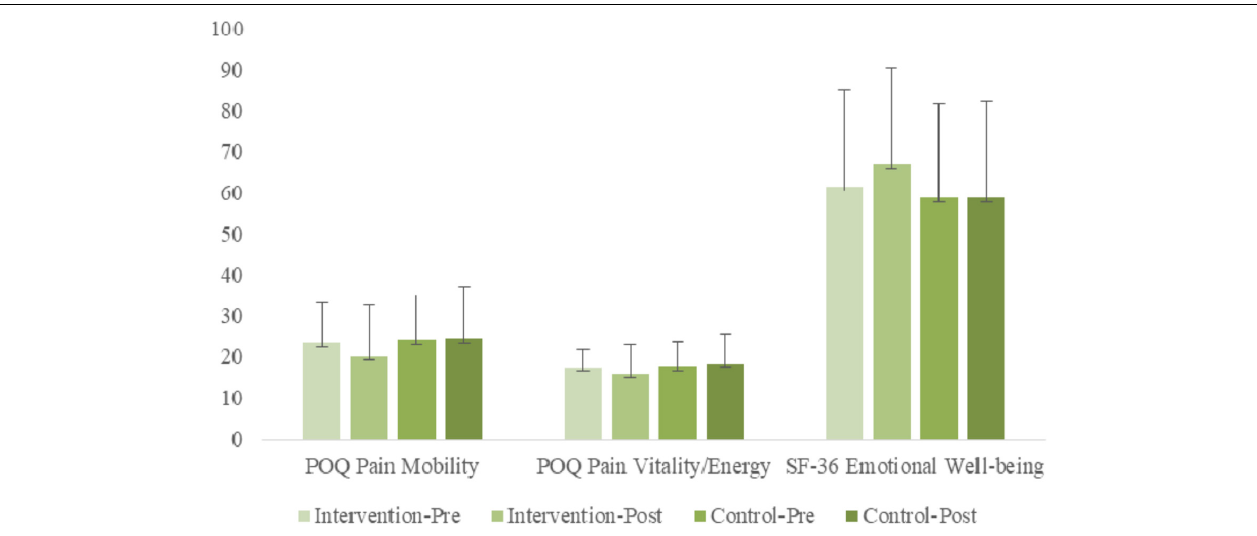
FIGURE 5 | Pre- and post-treatment comparisons of treatment and control groups on strengths variables: POQ Pain Mobility is Pain Impairment in Mobility; POQ Pain Vitality/Energy is Pain Impairment in Vitality/Energy; Emotional Well-being of Positive Emotions. TABLE 3 | Means, standard deviations, and ANOVA results for intervention and control groups. Pretreatment Posttreatment